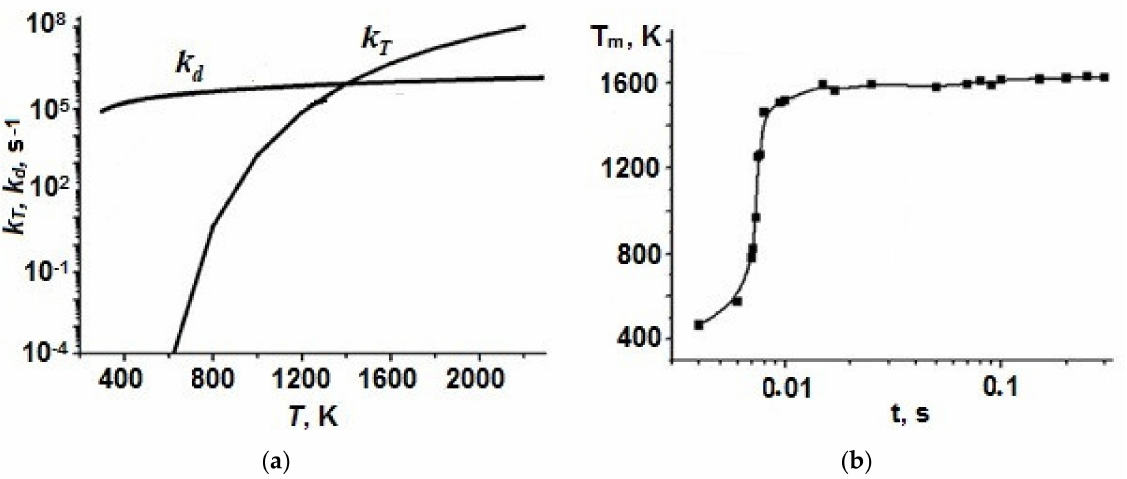
Figure 6. ( a ) Rate constants of thermal dissociation ( k T ) and electron impact dissociation ( k d ) at microwave field 1.5 × 10 4 V/cm and electron density n e = 10 14 cm − 3 ; and ( b ) change of maximum gas temperature in